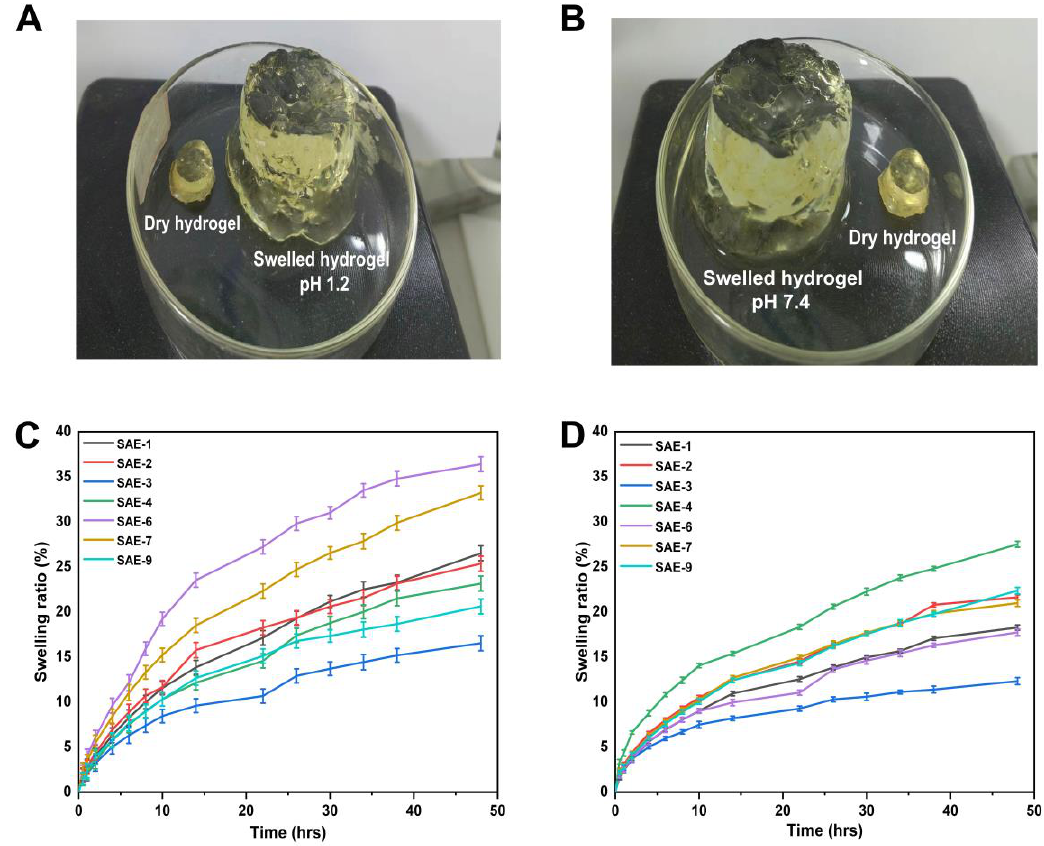
Figure 8. The appearance of synthesized hydrogels at pH 1.2 ( A ) and pH 7.4 ( B ). Hydrogel swelling curves over time at pH 1.2 ( C ) and 7.4 ( D ).